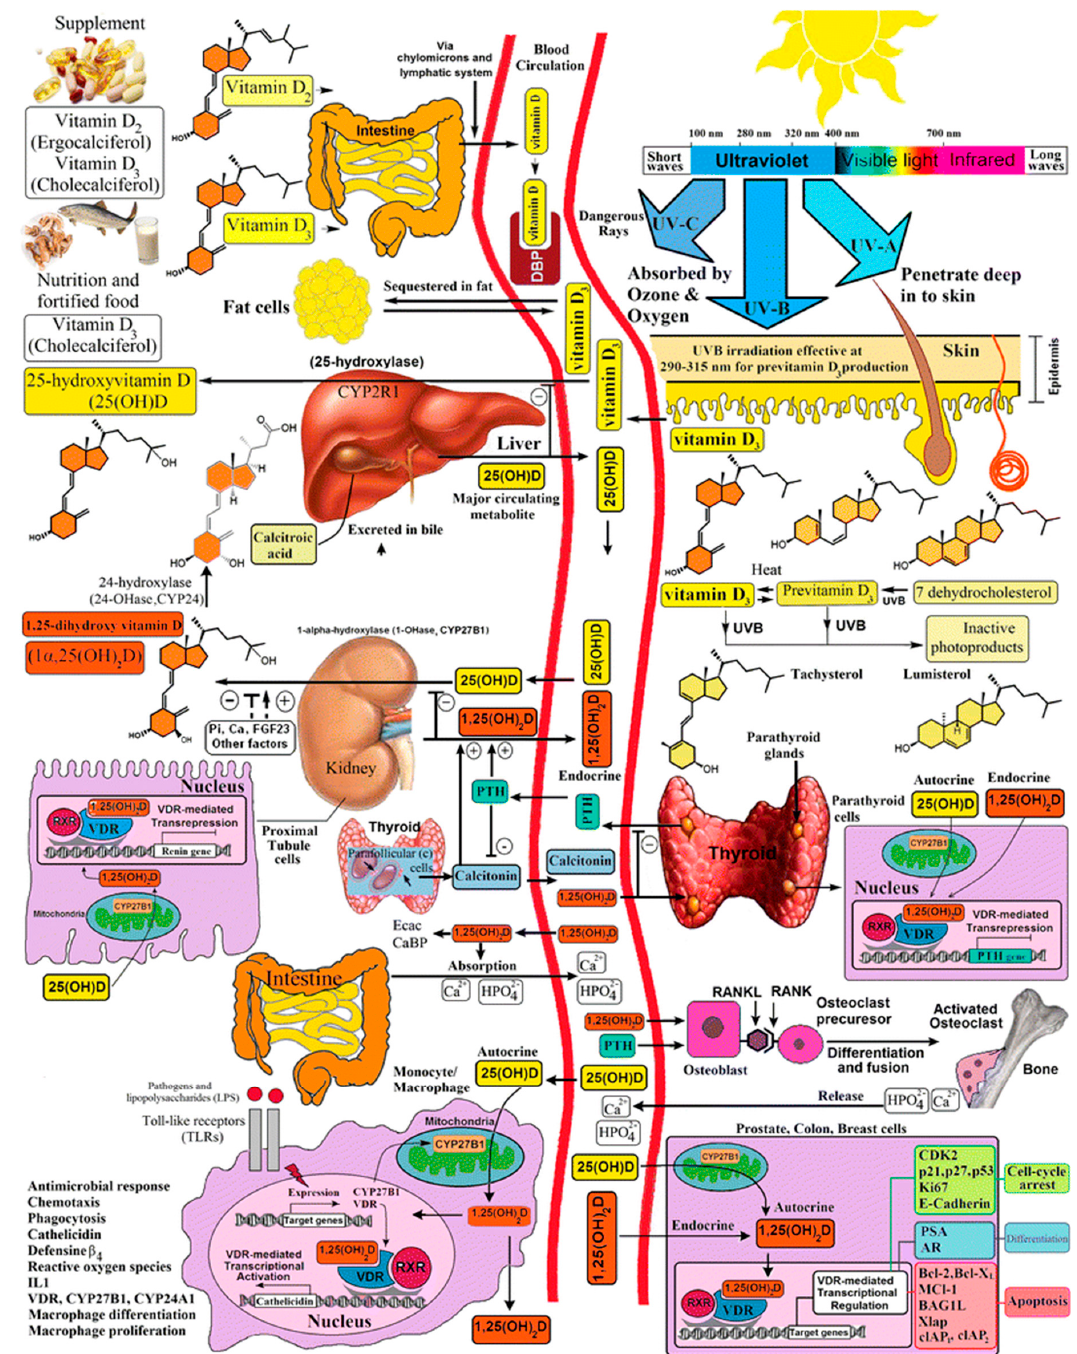
Figure 1. This schematic diagram highlights the complex interplay between a number of organs, and circulating forms of vitamin D, calcium, phosphate, and hormones involved with vitamin D metabolism and calcium homeostasis (shown within the two continuous red lines representing blood circulation). The top right hand corner depicts skin sun UV B exposure and vitamin D production in the skin, followed by 25 hydroxylation in the liver producing the storage form of vitamin D, 25 OH vitamin D, which is the form of vitamin D routinely measured in commercial assays. Inflammatory and paracrine roles of 1,25 (OH) 2 vitamin D are also shown in the bottom left hand corner. Copyright permission was obtained from the publisher. [9].